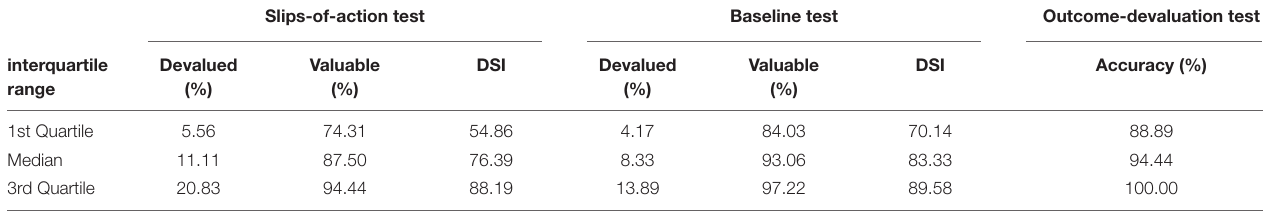
TABLE 3 | Task performance in the slips-of-action, baseline, and outcome-devaluation tests (1st Quartile, Median, and 3rd Quartile). Slips-of-action test Baseline test Outcome-devaluation test